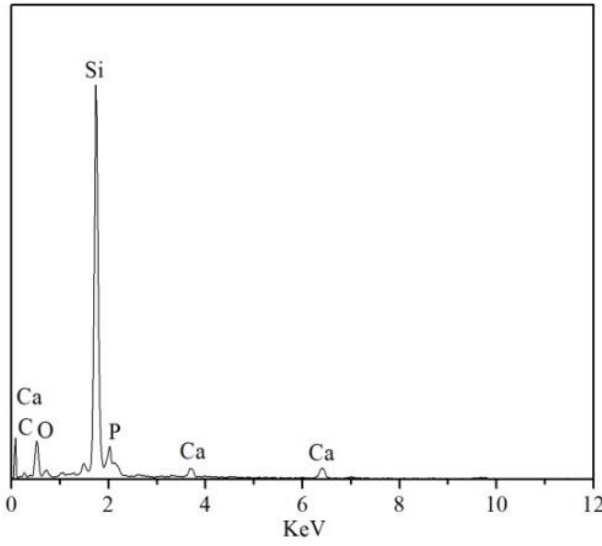
Figure 6. EDS analysis results of SN20 pin against UHMWPE disc (point 1).